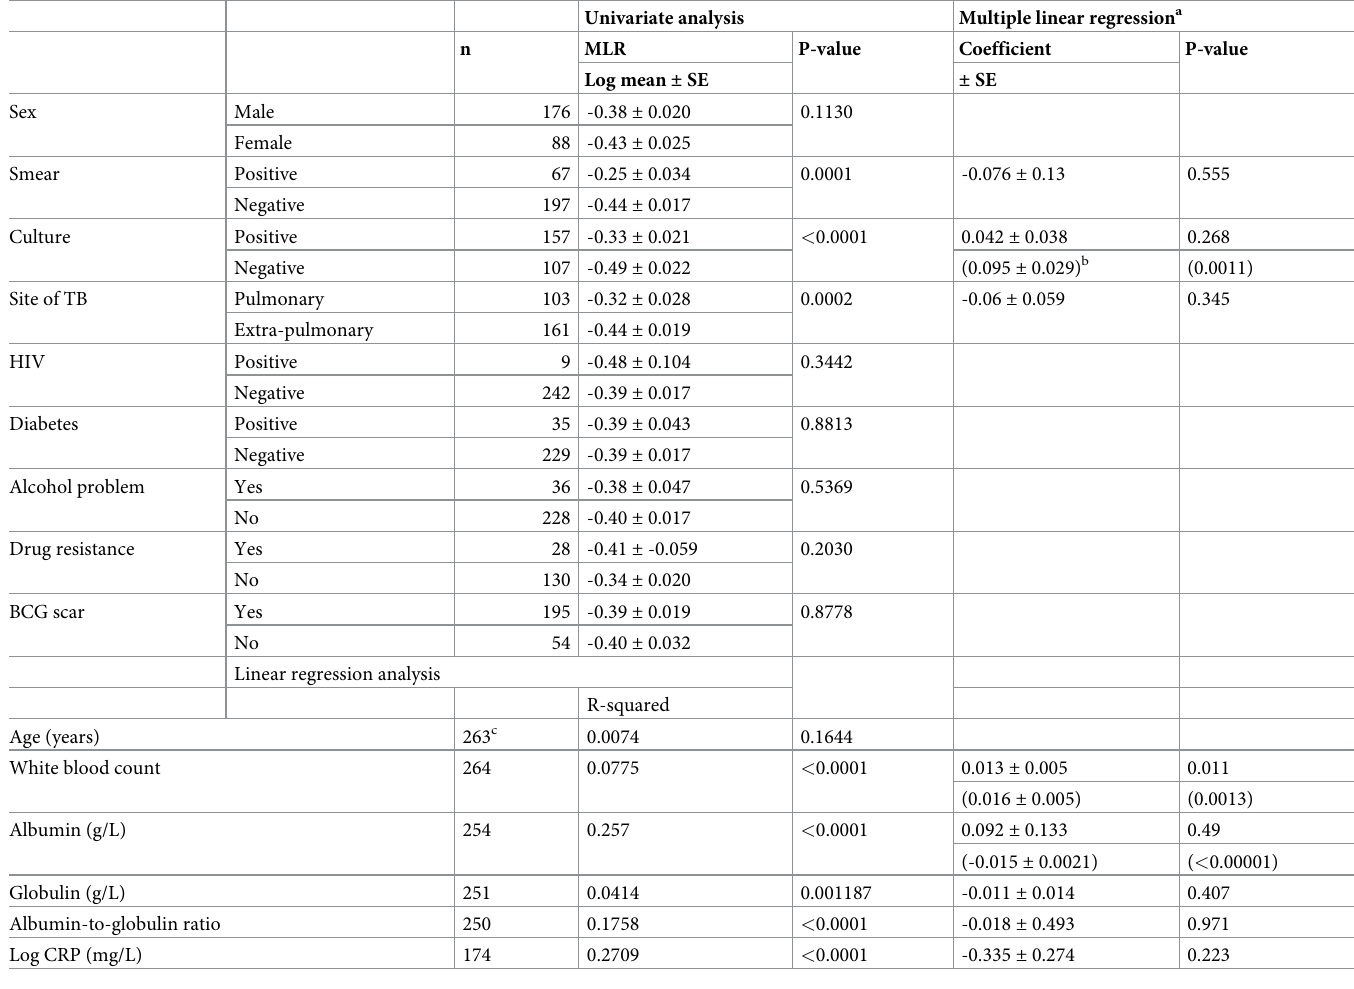
Table 2. Univariate and multivariable regression analysis of MLRs in